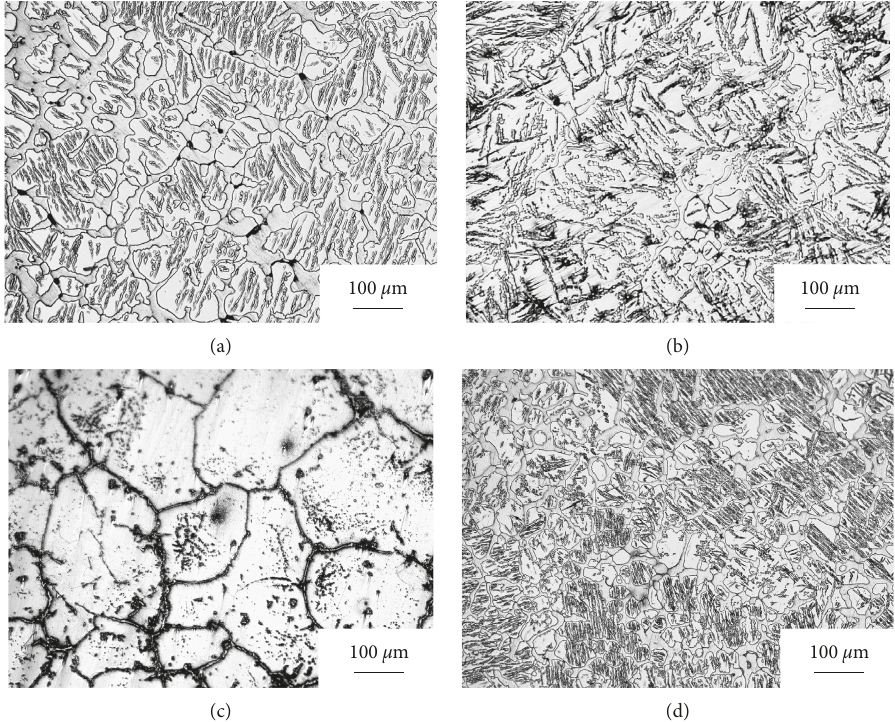
Figure 1: Optical micrographs of the as-cast (a) C1, (b) C2, and (c) C3 samples at 30mm and (d) C1 at 5mm thickness.